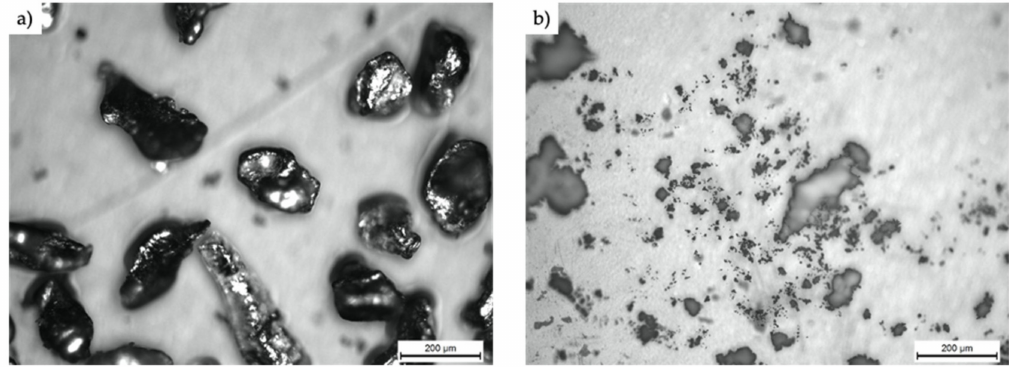
Figure 1. Optical micrographs of ( a ) the magnesium powder and ( b ) the hydroxyapatite (HAP) powder. Mg powders have a random but still completely rounded shape with an average size of 180 µ m.